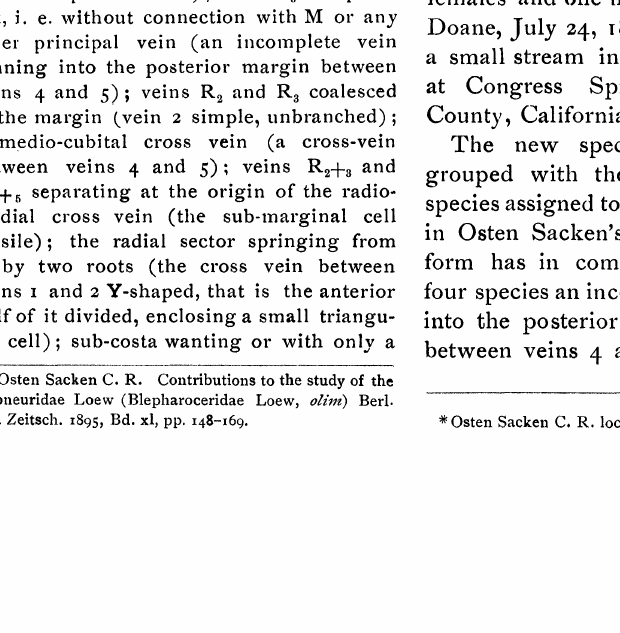
Fig. 2. Venation ot L@oneura doanei n.